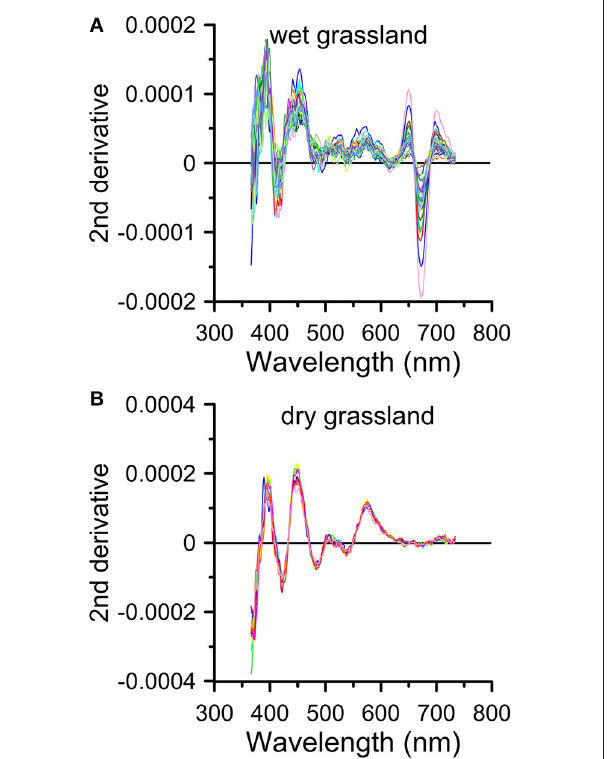
UV-Vis spectrophotometer at a scan rate of 30 nm/min from